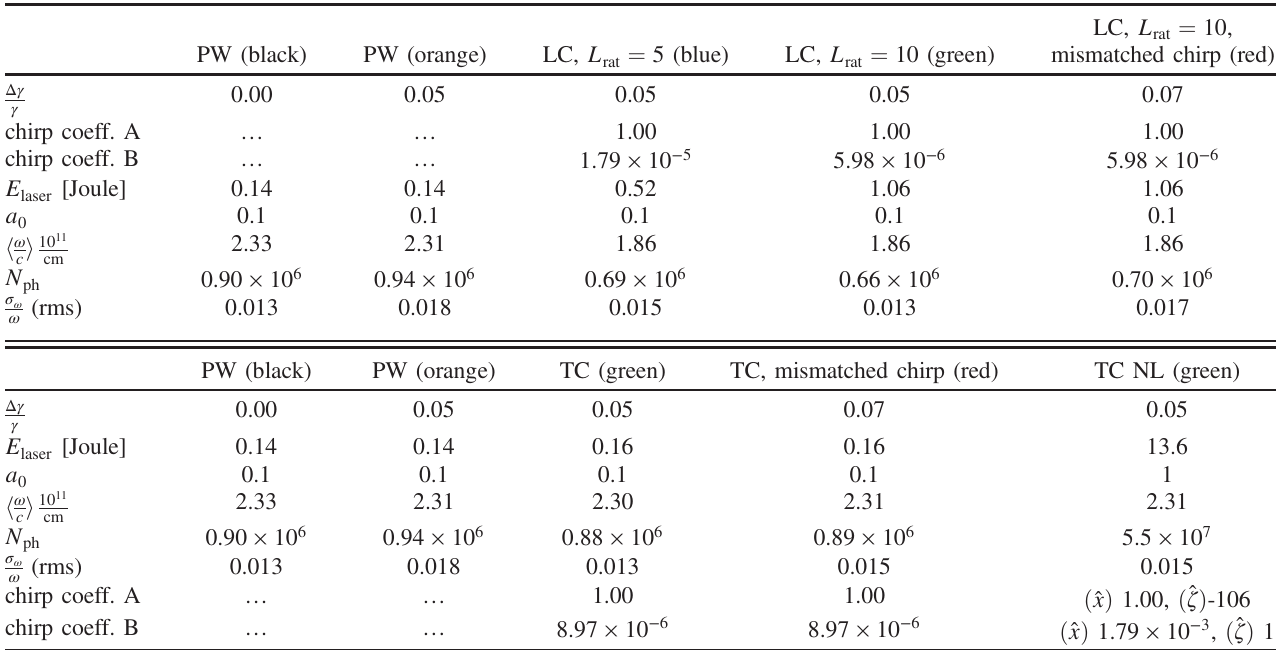
TABLE I. Parameters of Fig. 6 with the same color code: Energy of the laser pulse, the energy spread of the electrons, the chirp coefficients as described in Eq. (13) and (21), the laser strength parameter of the pulse, the peak frequency, bandwidth and number of photons of the emitted radiation. These numbers are for a single laser pulse – electron bunch collision. For all the chirped cases a ¼ 0 . 14 has been used. frequency bandwidth of Δ ω B ω l; 0